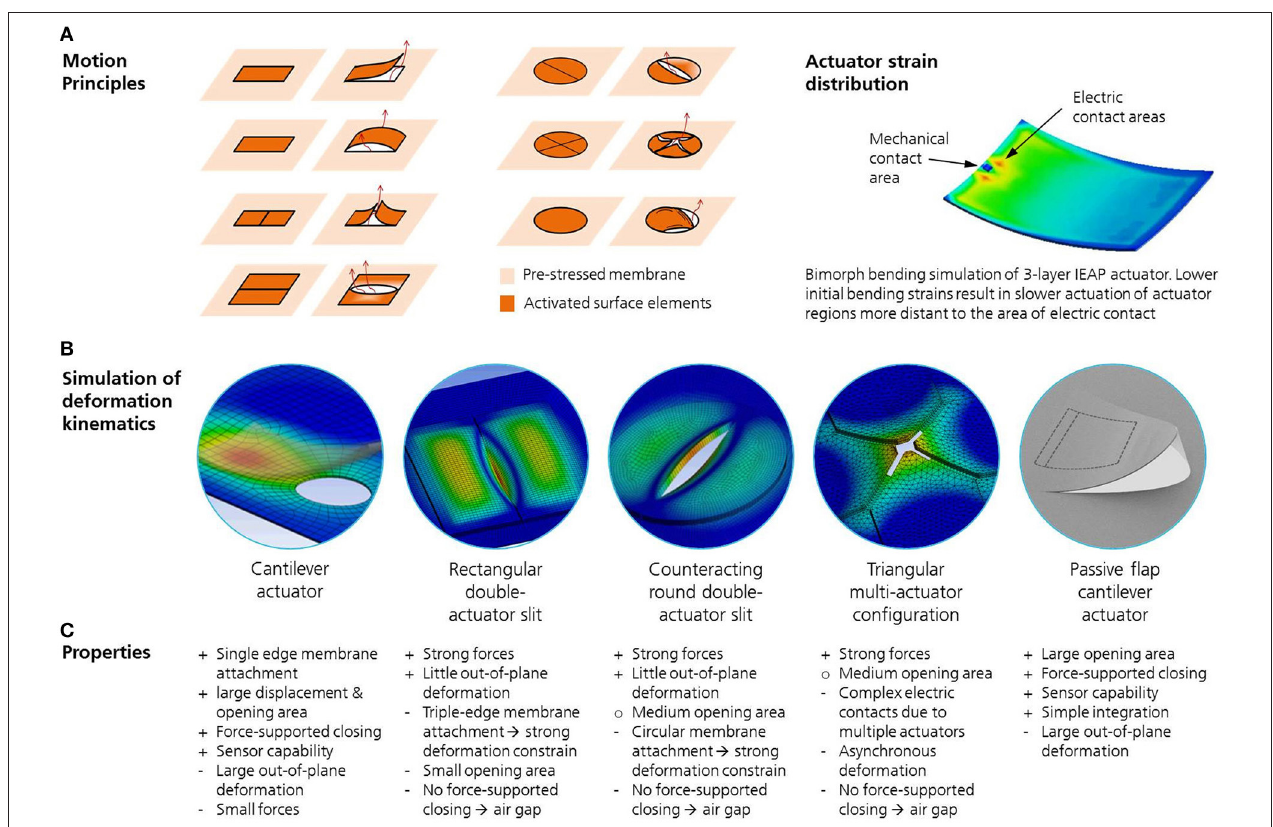
FIGURE 6 | (A) Motion principles and (B) kinematic simulations for thin and flexible soft actuators generating controllable apertures in pre-stressed membrane structures. (C) Properties of actuating aperture concepts.